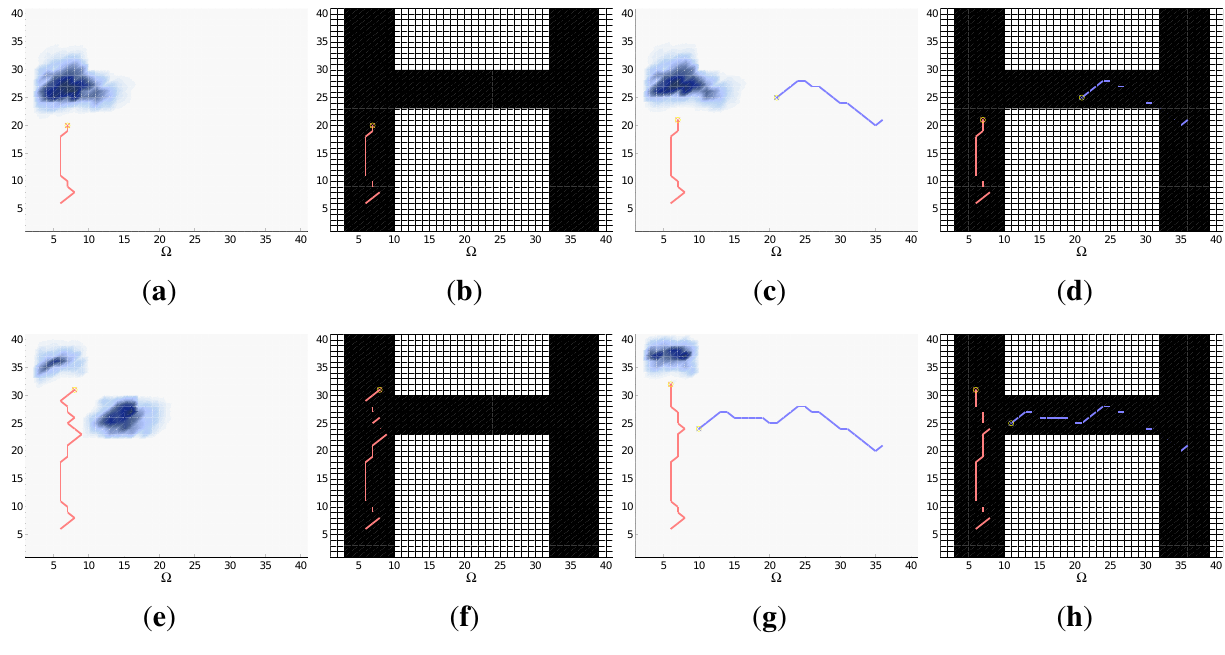
Figure 13. Simulations in the dynamic ultrasonic scanner scenario. ( a ) k = 15 , M = 1 ; ( b ) k = 15 , M = 1 ; ( c ) k = 15 , M = 2 ; ( d ) k = 15 , M = 2 ; ( e ) k = 25 , M = 1 ; ( f ) k = 25 , M = 1 ; ( g ) k = 25 , M = 2 ; ( h ) k = 25 , M = 2